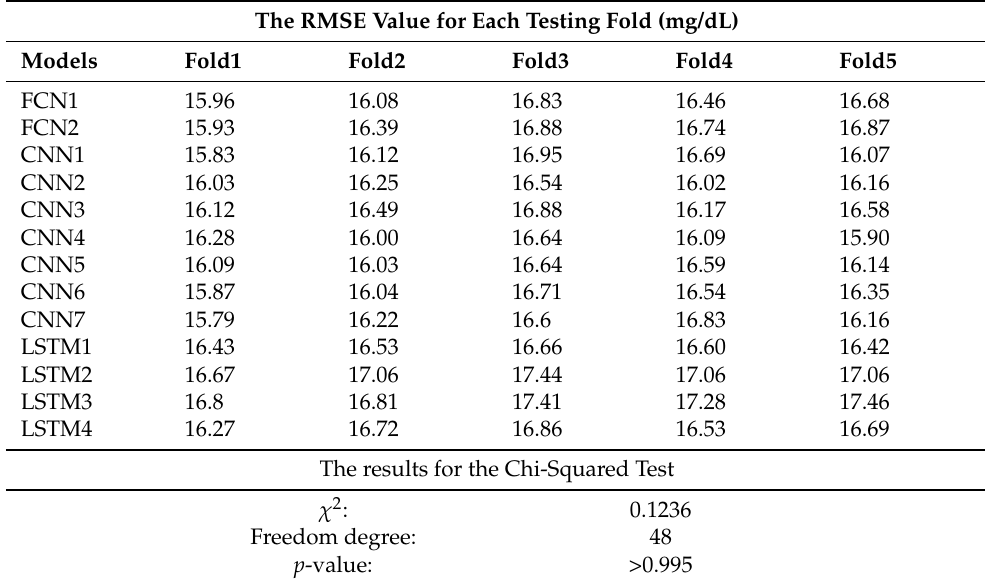
Table A3. The prediction RMSE for the five testing folds and the results of the Chi-squared test. The RMSE Value for Each Testing Fold